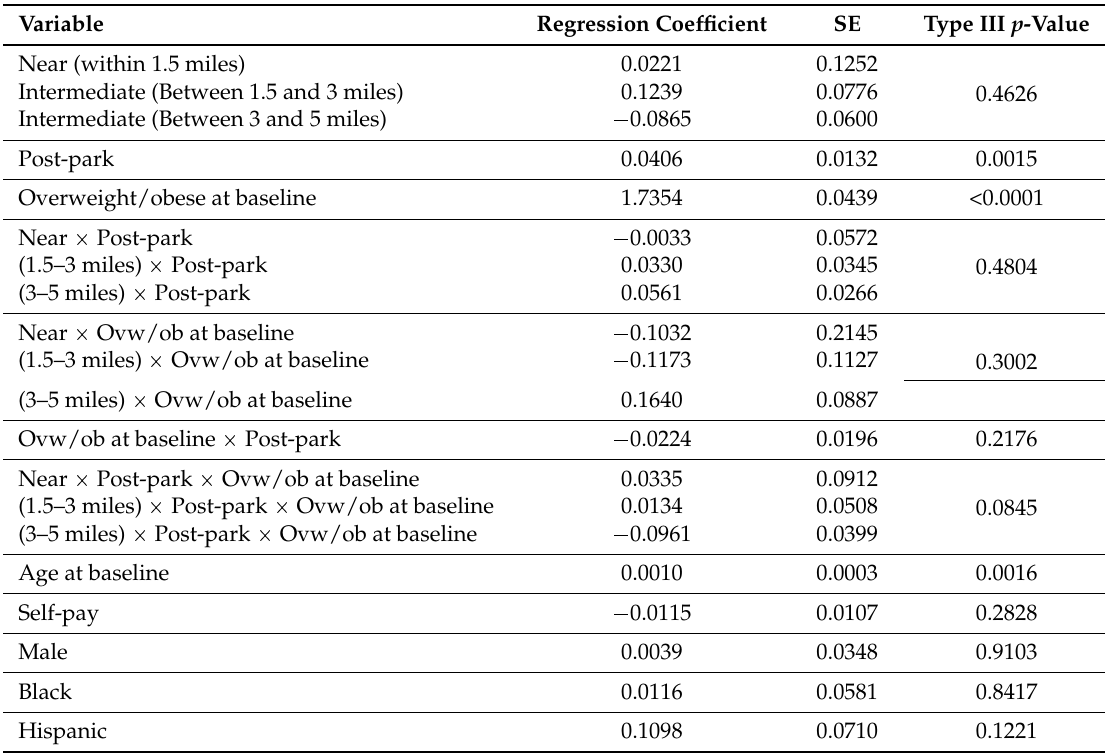
Table 4. Relationship between the interaction between the park, being near to the park, and BMI z-scores controlling for baseline BMI compared to children living far from the